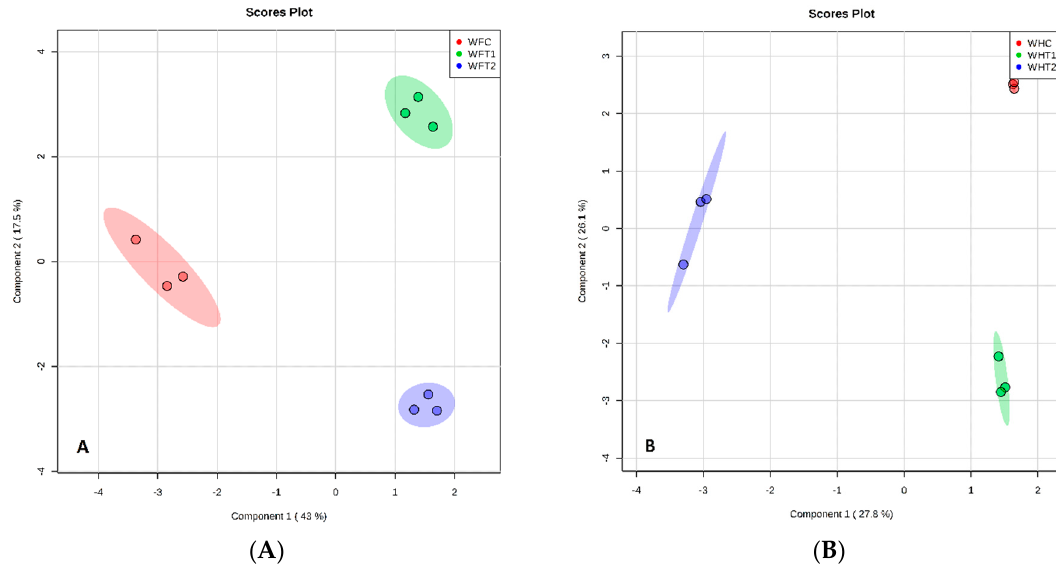
Figure 5. sPLS-DA model obtained from the classification of rhizosphere from Floribunda and Hybrid Tea roses samples based on VOCs according to BA treatments. ( A ) Score plot of Floribunda and ( B ) for the Hybrid Tea rhizosphere. Red, green and blue colors indicated groups of treatments. R represents rhizosphere, F represents Floribunda, H represents Hybrid Tea. While C represents control, T1 and T2 represent 100 and 200 mg/L BA, respectively. Three dots in each group mean n = 3 biological replicates.